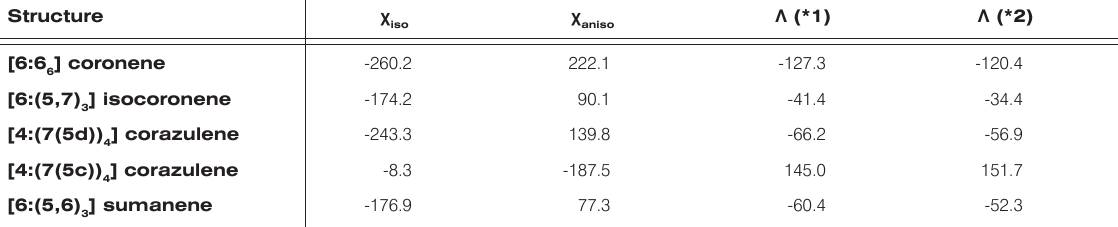
), anisotropic ( χ iso